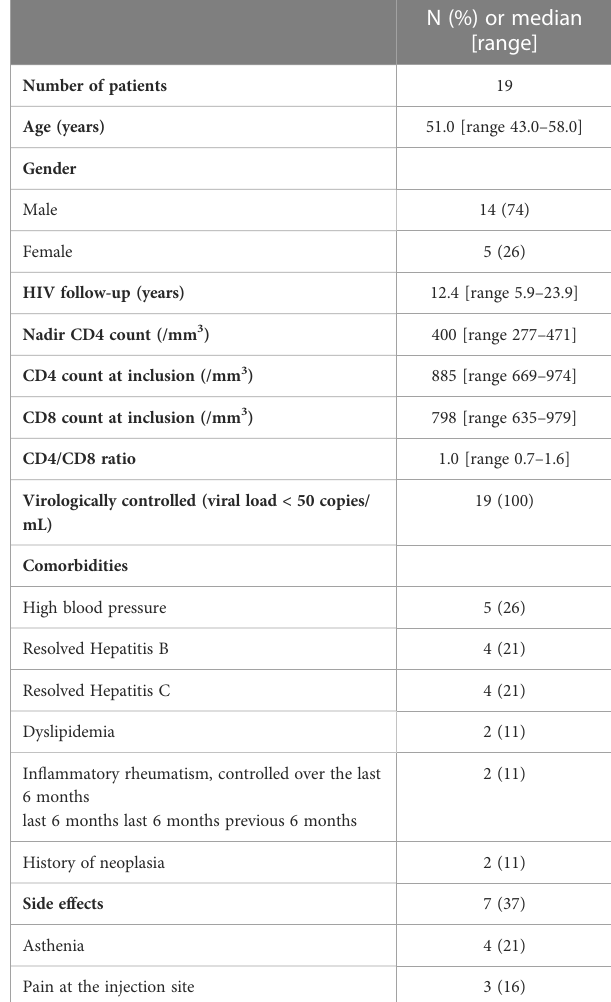
TABLE 1 Patient characteristics at